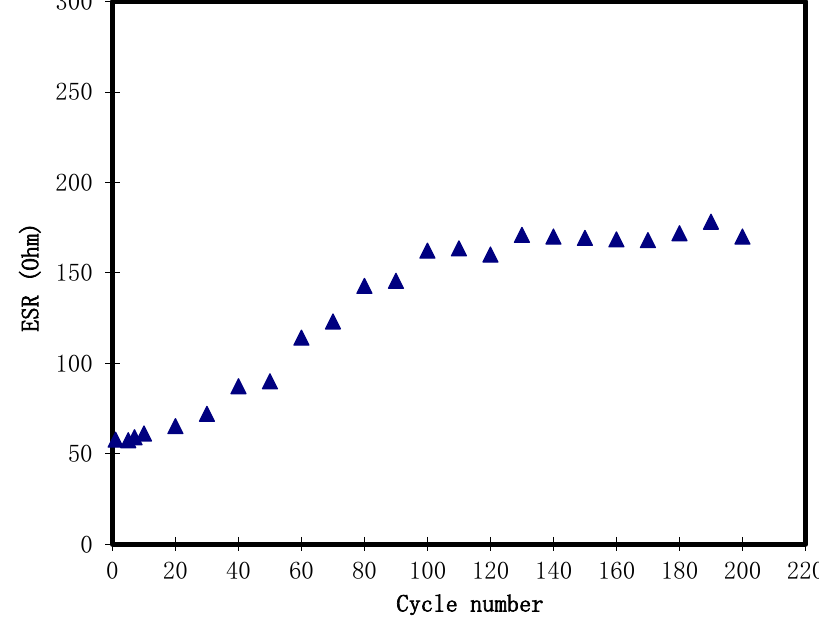
Figure 8. The plot of ESR of the fabricated EDLC for 200 cycles.